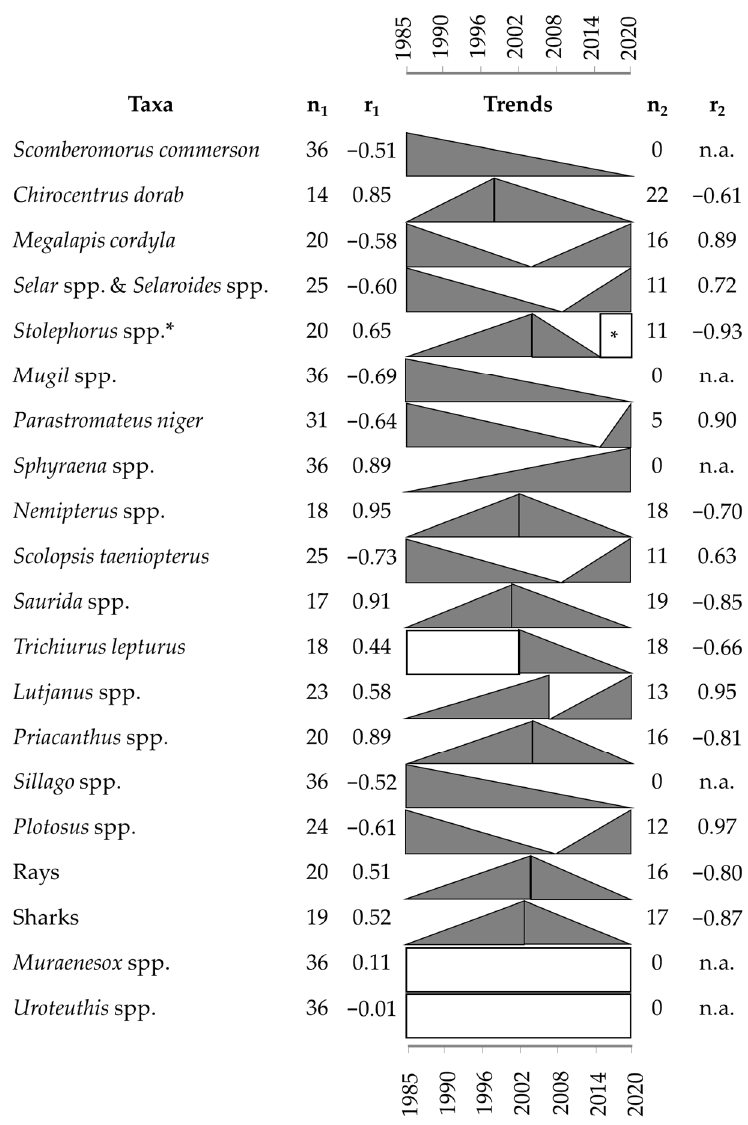
Figure 5. Trends in fish landings of the high and high-medium vulnerability taxa from the trawl fisheries in the Gulf of Thailand from 1985 to 2020. From the left: taxa, number of years (n 1 ) and Spearman correlation (r 1 ) for the first subseries, representation of the trend, number of years (n 2 ) and Spearman correlation (r 2 ) for the second subseries. Note * no trend in fish landings has been observed in Stolephorus spp. since 2019.